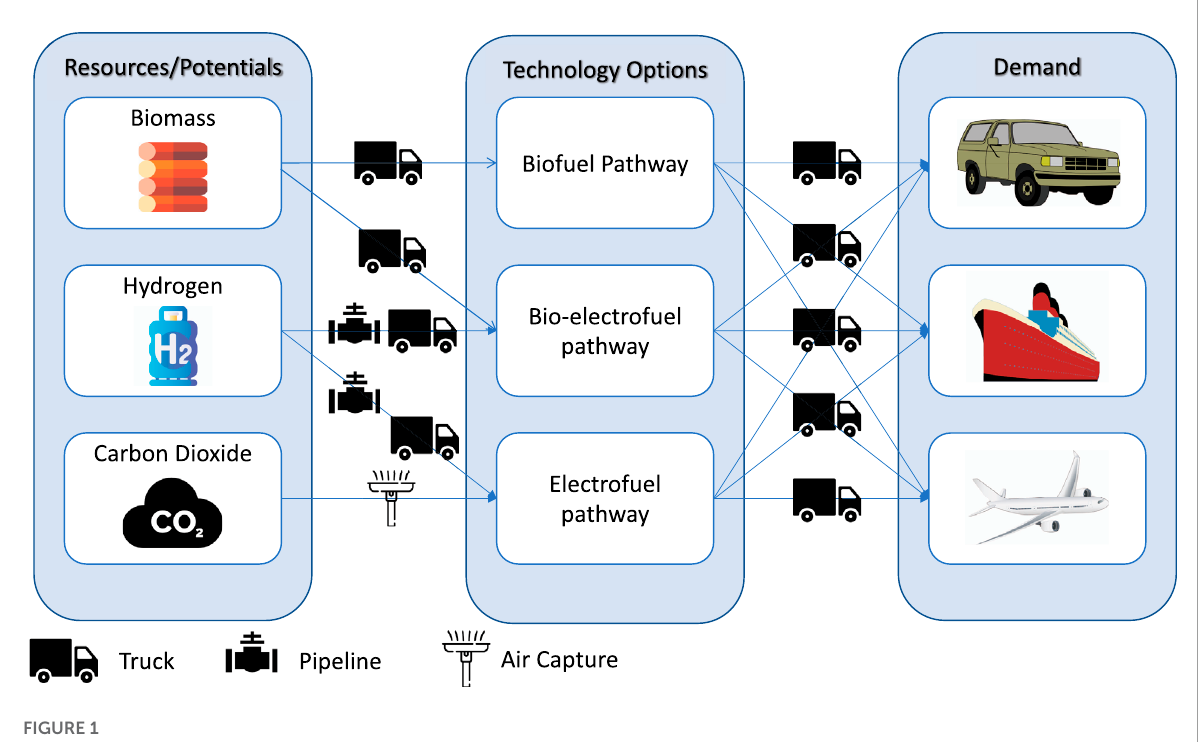
FIGURE 1 Overview of the structure of renewable fuel production